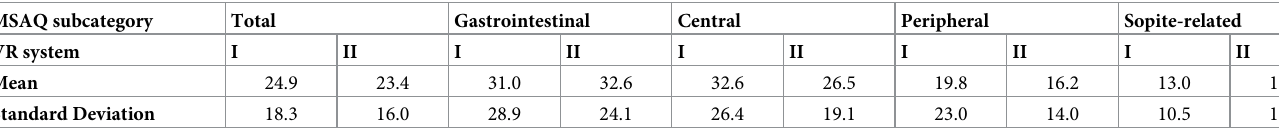
Table 8. Mean and SD of MSAQ subcategories for the training sessions.